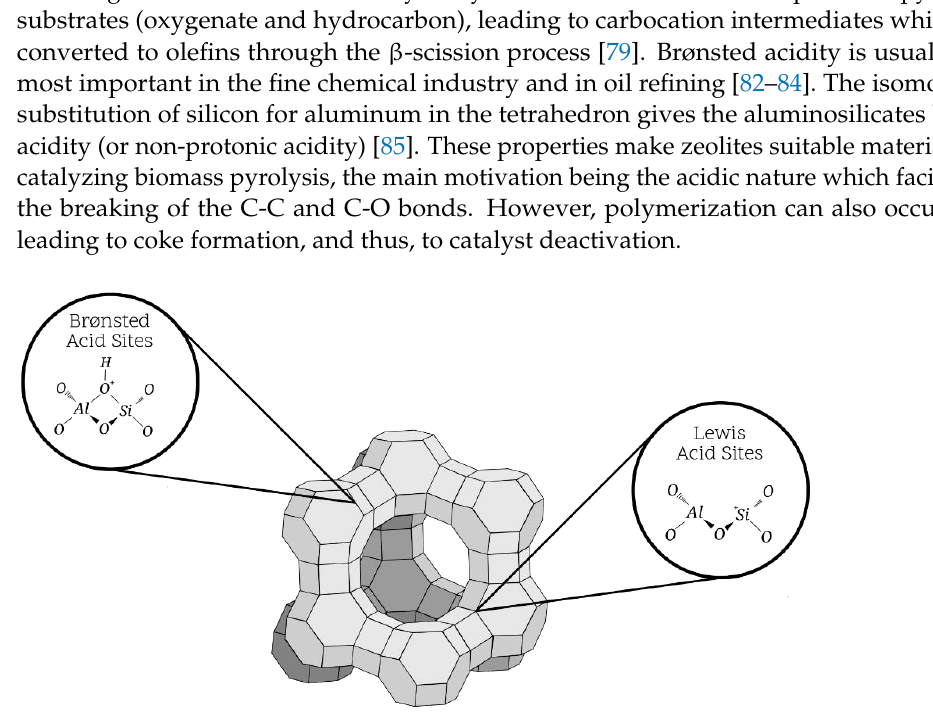
Figure 7. Generation of acidity in zeolites. The Lewis acid sites are generated by the non-balancing and dislocated charges due to the replacement of silicon by aluminum ions. The Brønsted acid sites are created by the counterbalancing of charge by cationic species.